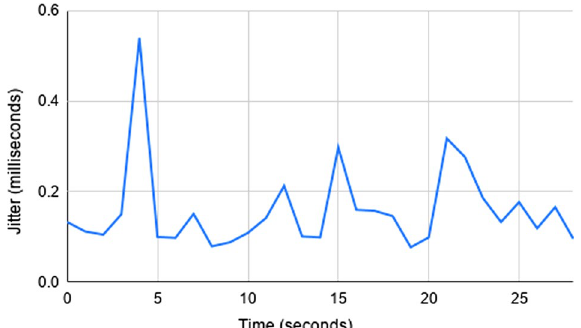
Fig. 6 iperf3 test results for jitter on the testbed for a 30 s window connecting from an edge device to the cloud services host